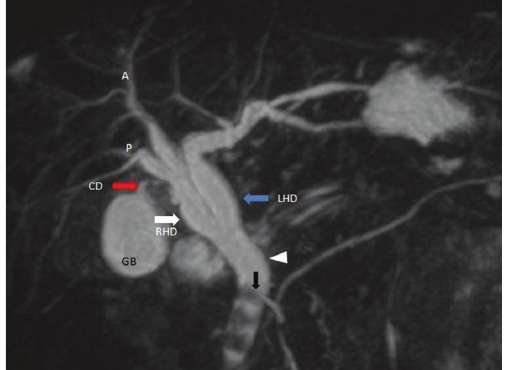
Figure7:Coronaloblique3DMRcholangiopancreatographyshows aberrant insertion of cystic duct (red arrow) into the right hepatic duct (white arrow) and low union of right and left hepatic duct (blue arrow).Alsonotemultiplecalculi(blackarrow)incommonbileduct (white arrowhead). A: right anterior sectoral duct, P: right posterior sectoral duct, RHD: right hepatic duct, LHD: left hepatic duct, CD: cystic duct, and GB: gall bladder.